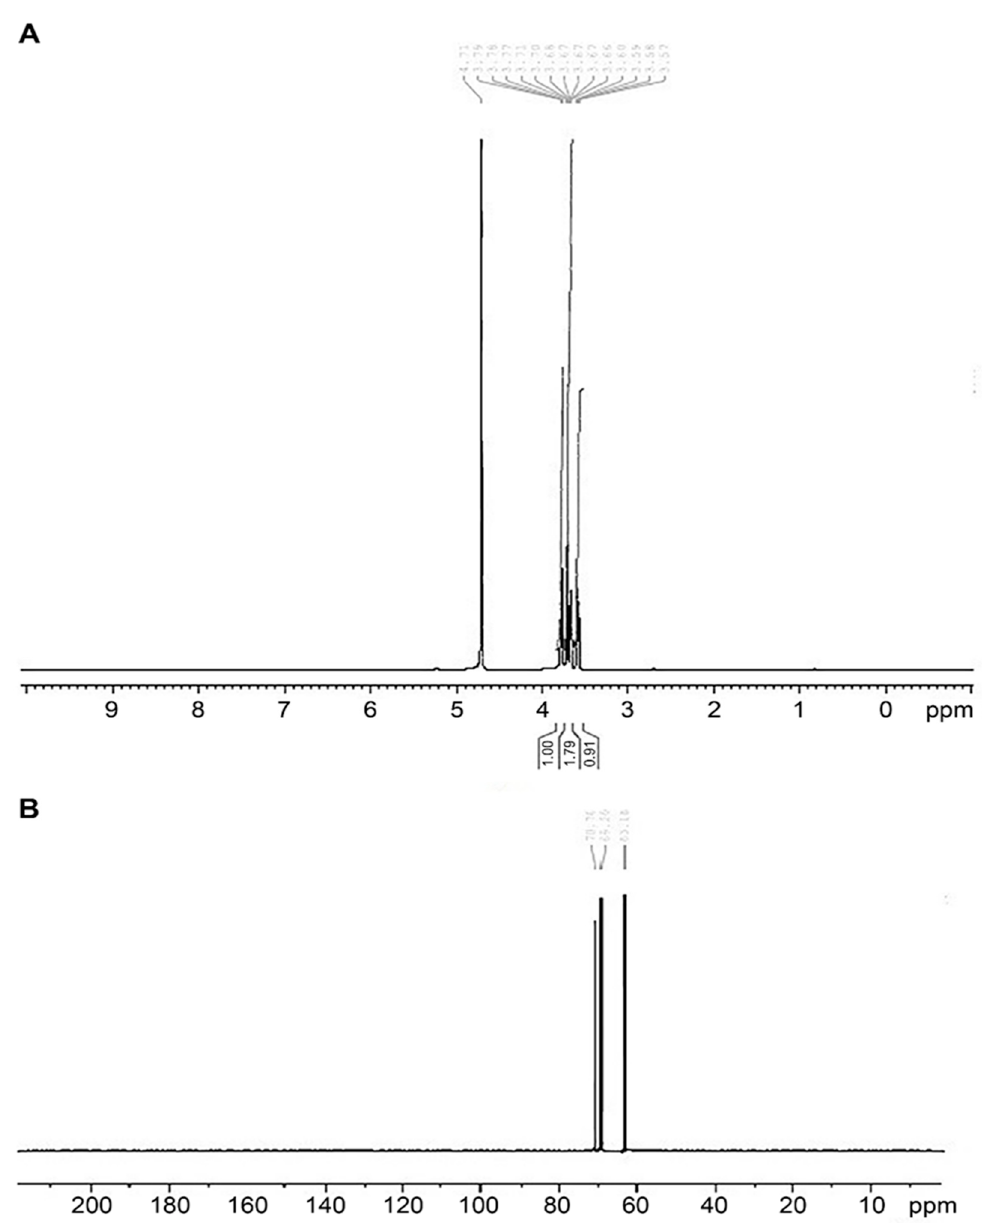
Figure 5. Nuclear magnetic resonance study of lyophilized recombinant HBsAg-loaded docosahex- aenoic acid nanovesicles; ( A ) 1 H-NMR spectrum; ( B ) 13 C-NMR spectrum